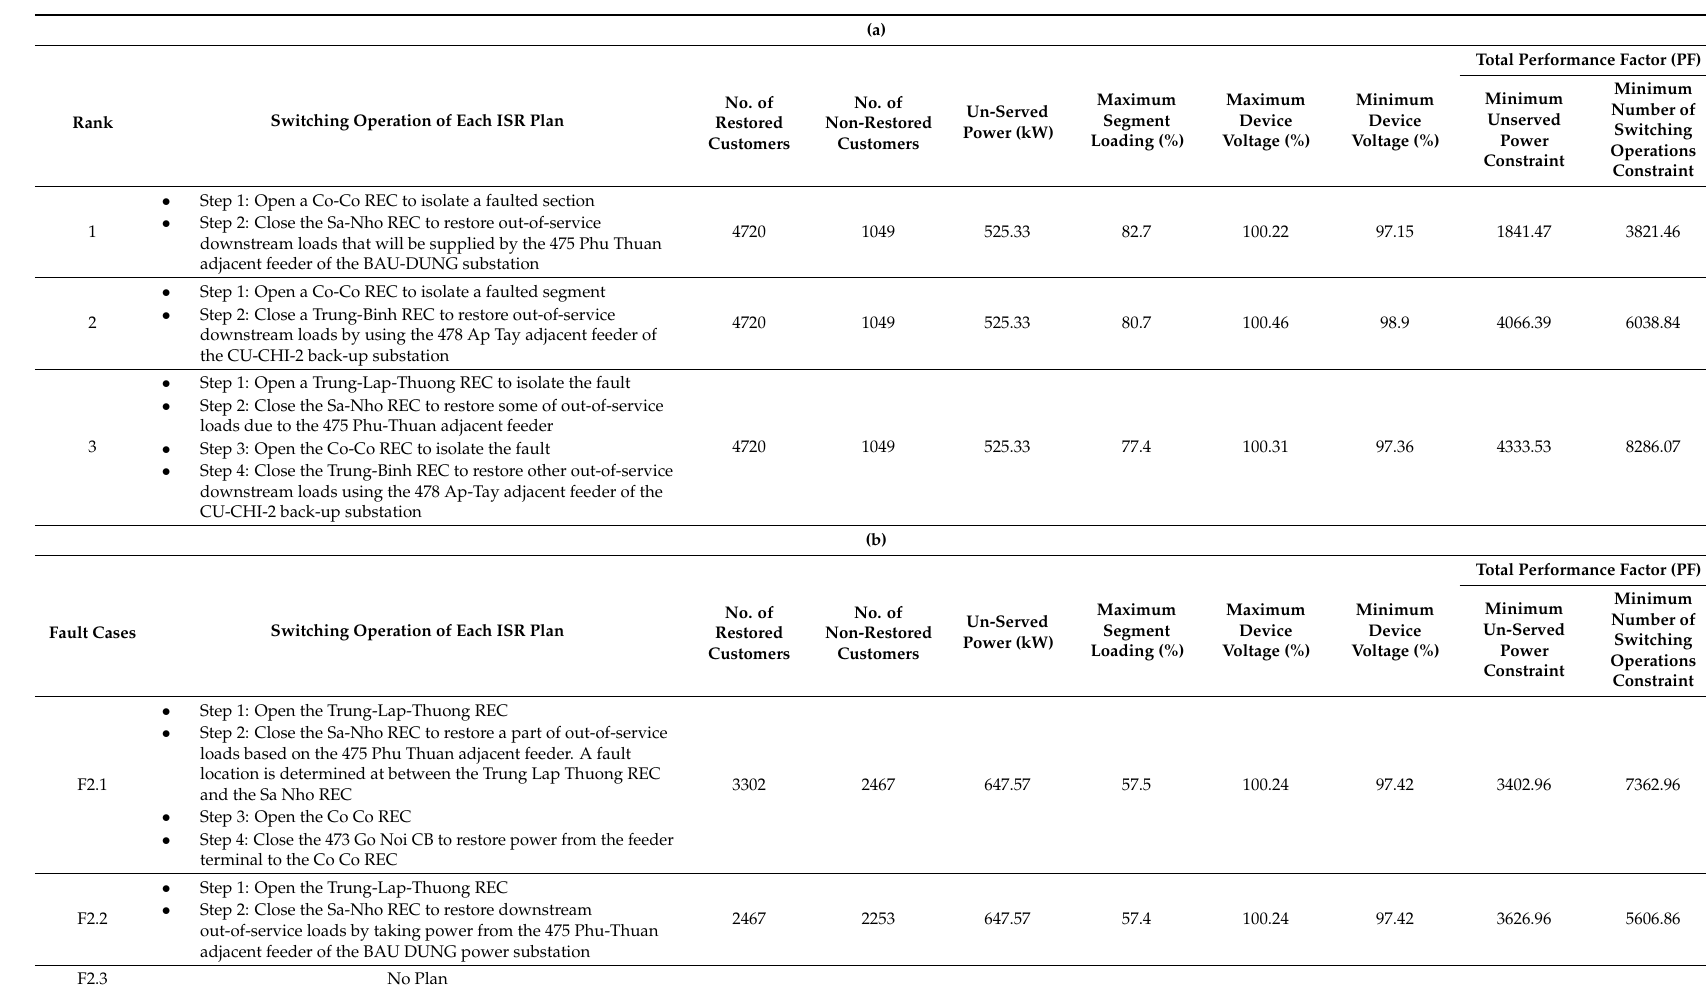
Table 22. ( a ) The number of switching steps and all possibly ranked ISR plans with respect to faults at F1. ( b ). The number of switching steps and all possibly ranked ISR plans with respect to fault cases at F2. ( c ) The number of switching steps and all possibly ranked ISR plans with respect to fault cases at F3.